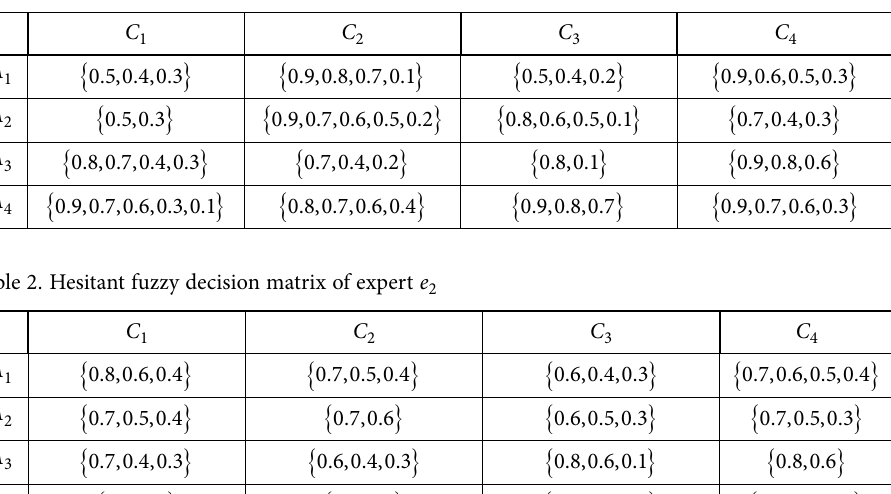
Table 1. Hesitant fuzzy decision matrix of expert e 1